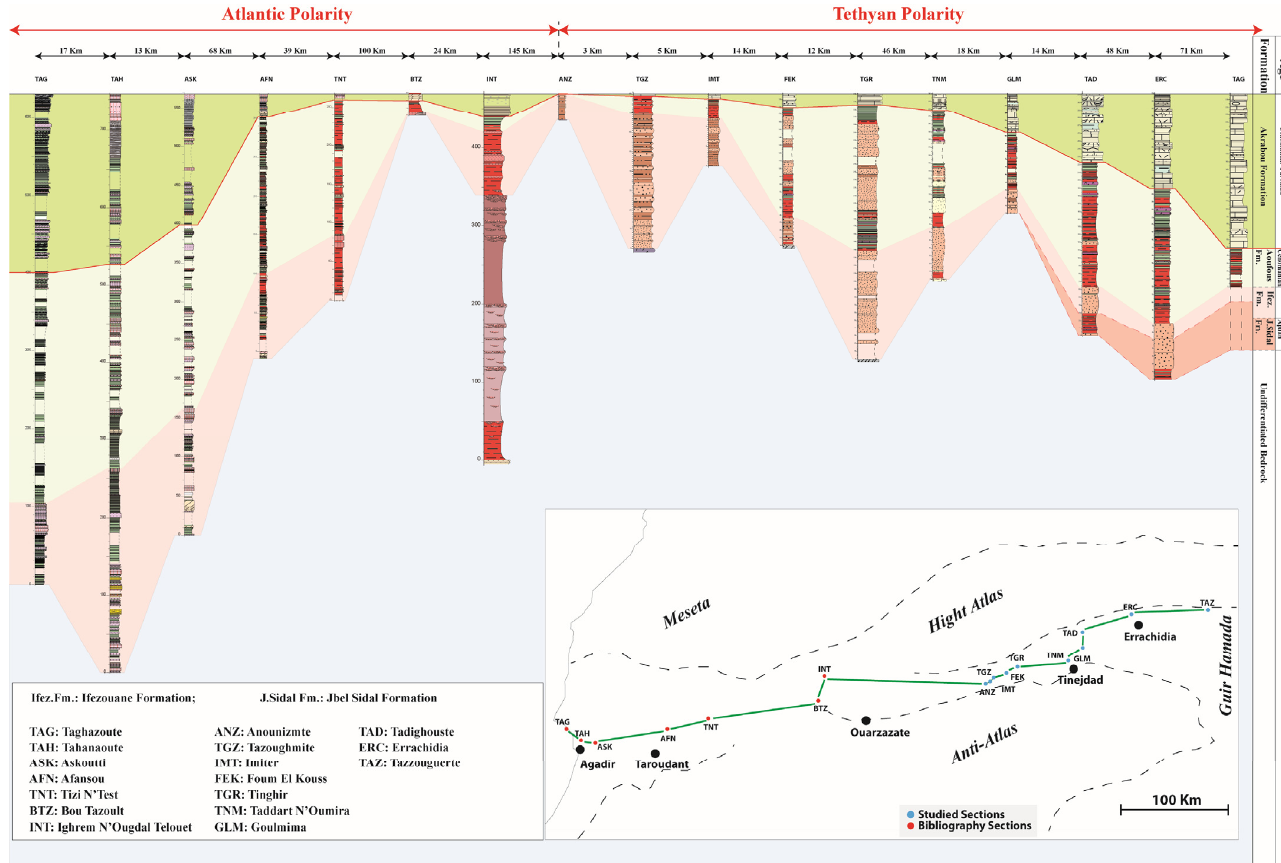
Figure 15. Correlation of the studied sections in the Errachidia–Boudnib–Erfoud Basin, with other sections in the Ouarzazate and Agadir basins along the Agadir–Tazzouguerte east–west transect. The seven western sections on the transverse are from [17,39,57].